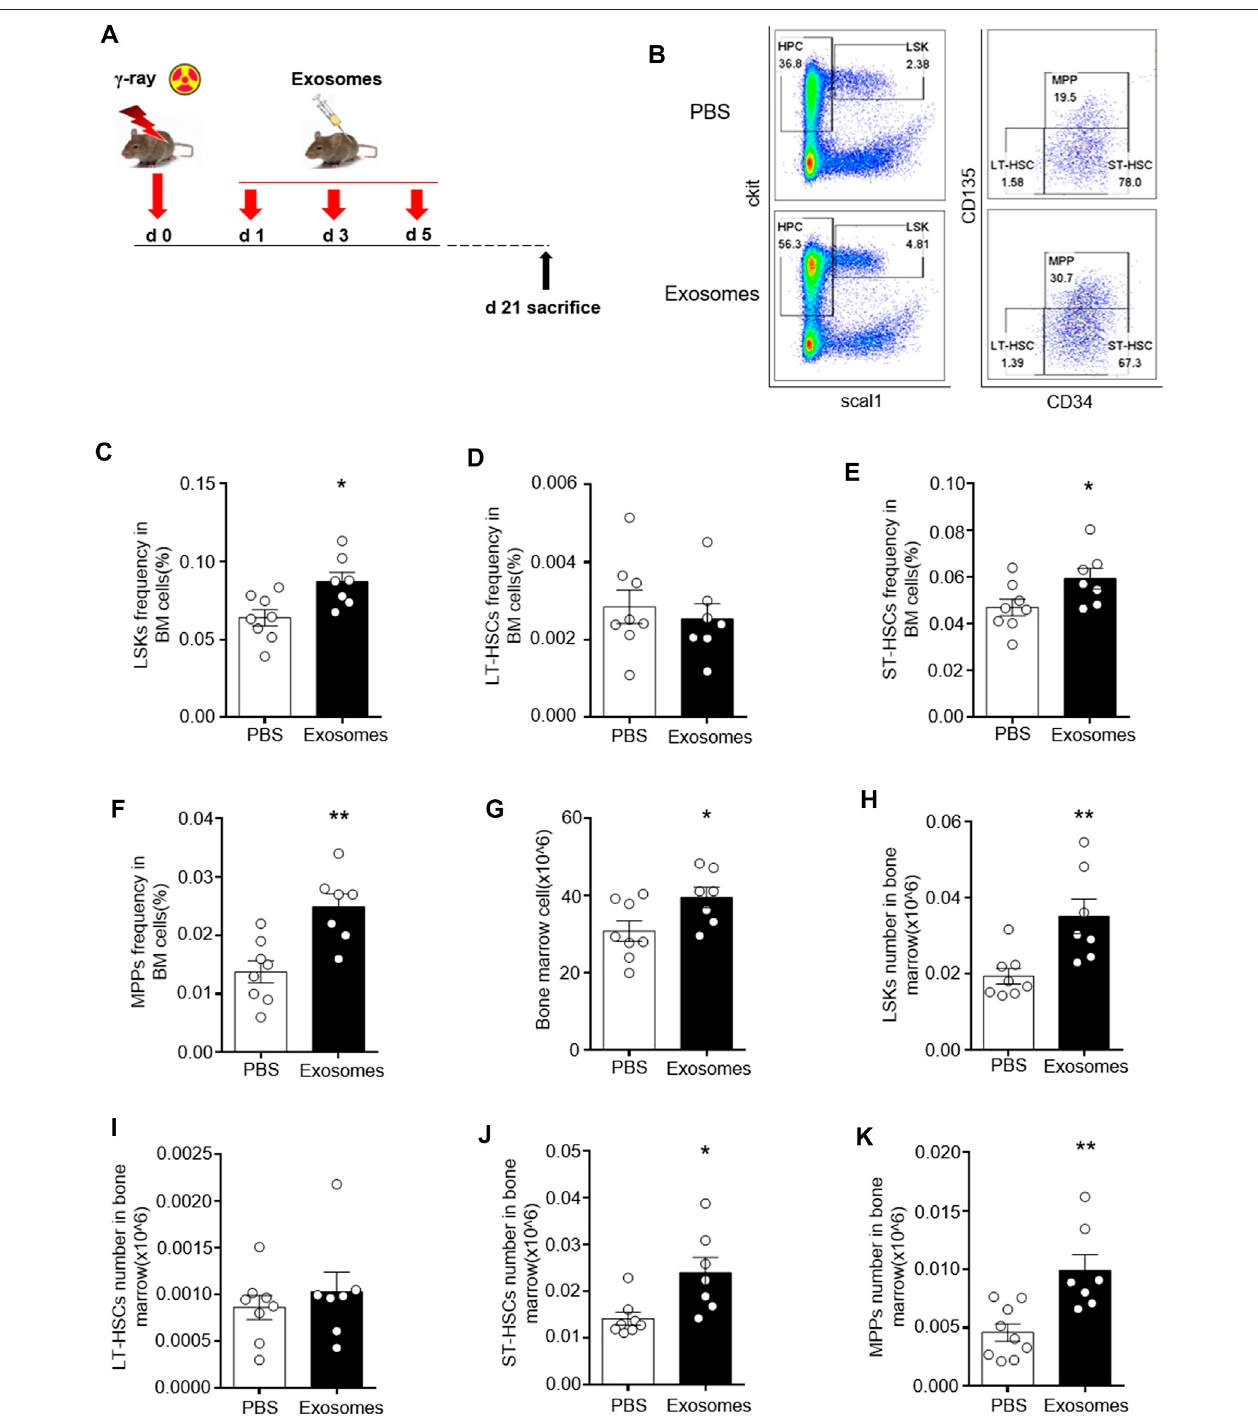
FIGURE 2 | Osteoblast derived exosomes mitigate irradiation injury to hematopoietic stem and progenitor cells. (A) The mice were injected with PBS or OB- exosomesimmediatelyafter5 GyTBIat1st,3rd,5thdayafterirradiation. (B) RepresentativeFACSplotsofLSKcells,MMP,LT-HSCandST-HSCweredetectedby fl ow cytometry. (C) TheLSKfrequency, (D) LT-HSC frequency (E) ST-HSC frequency, (F) MPPfrequency, (G) BM numbers, (H) LSKnumbers, (I) LT-HSC numbers, (J) ST- HSC numbers, (K) MPP numbers were analyzed 21 days after 5 Gy TBI. Statistical analysis of the hematopoietic stem cell number in irradiated mice injected with PBS ( n = 9) and osteoblast-exosomes (* p < 0.05, ** p < 0.01, mean ± sem, n = 7).